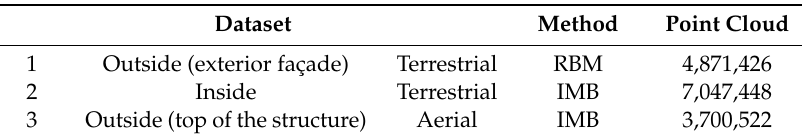
Table 2. Point Clouds Obtained in the Several Datasets.